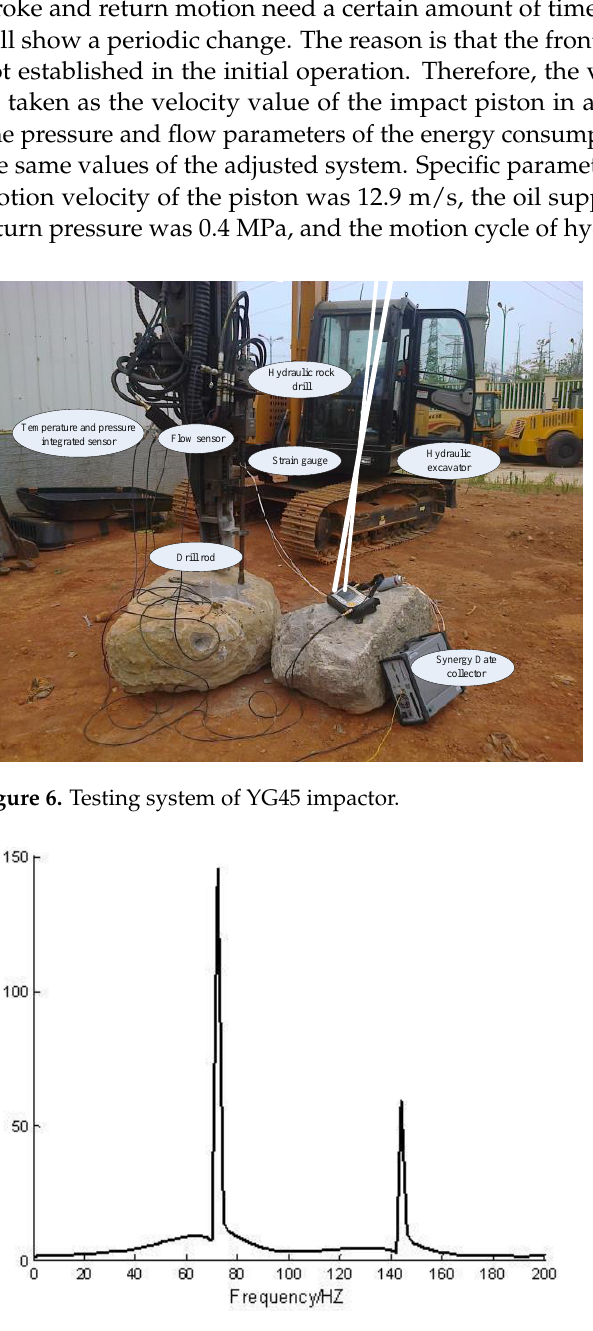
Figure 8. Velocity curve of impact piston under rated working condition. 5.2. Energy Consumption Analysis of Texture Impact Piston Pair A cylindrical texture unit was arranged on the surface of the impact piston, the length of the control unit along the 𝑥 axis 𝐿 𝑥 was 1.5 mm, and the length of the control unit along the 𝑦 axis 𝐿 𝑦 was 1.5 mm too. The area ratio textured was 30%, the dynamic viscosity of the hydraulic oil used was 0.06 P a · s , the initial oil film thickness was 27.5 μm, and the depth of cylindrical texture was 27.5 μm. The energy consumption model of the impact piston pair was calculated according to the above flowchart using MATLAB. The comparison of energy consumption between the non-textured impact piston pair and the cylindrical textured impact piston pair using the calculation results is shown in Figure 9. The results show that the energy consumption of the cylindrical textured impact piston pair was 14.63 J in one cycle under the above parameters. Comparing with the non-textured impact piston pair, the ratio of energy consumption to total energy loss was reduced by 5.88%. The surface friction force greatly reduces with the cylindrical texture, and the reduction in surface friction greatly improves the friction performance of the surface and reduces the friction loss a lot. In addition, the leakage loss increases slightly with the cylindrical texture. However, the increased leakage loss can be ignored compared with the reduced friction loss. The cylindrical texture makes the energy con-